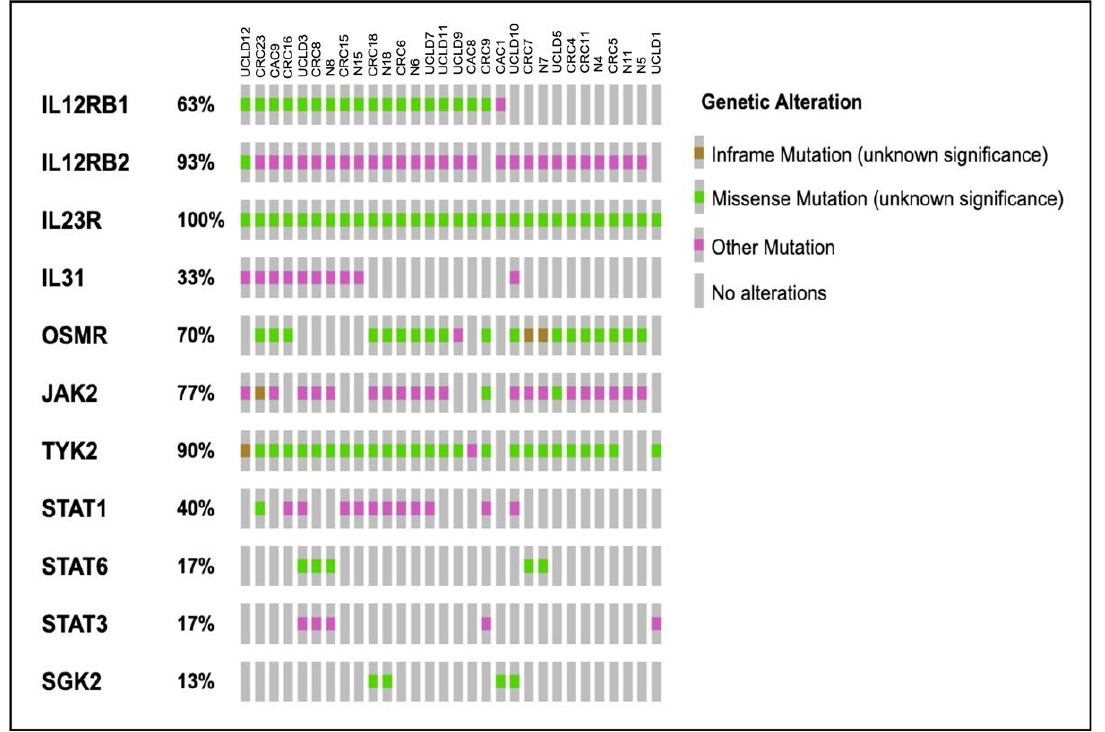
Figure 2. Oncoprint diagram showing the genetic alterations found in the exonic region of PI3K- related genes. Each bar represents the patient’s number [22,23].